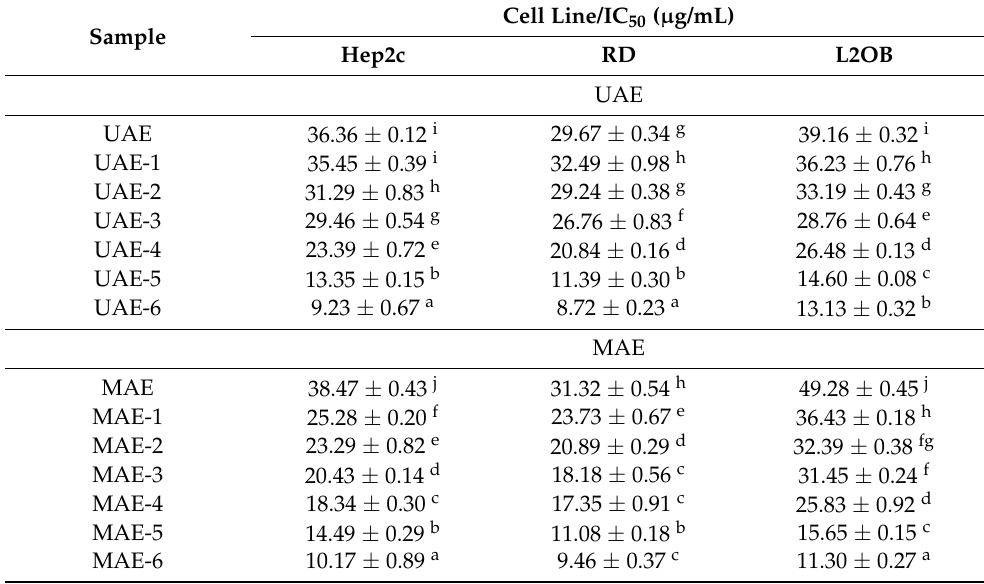
Table 6. Cytotoxic activity of extract obtained from exhausted